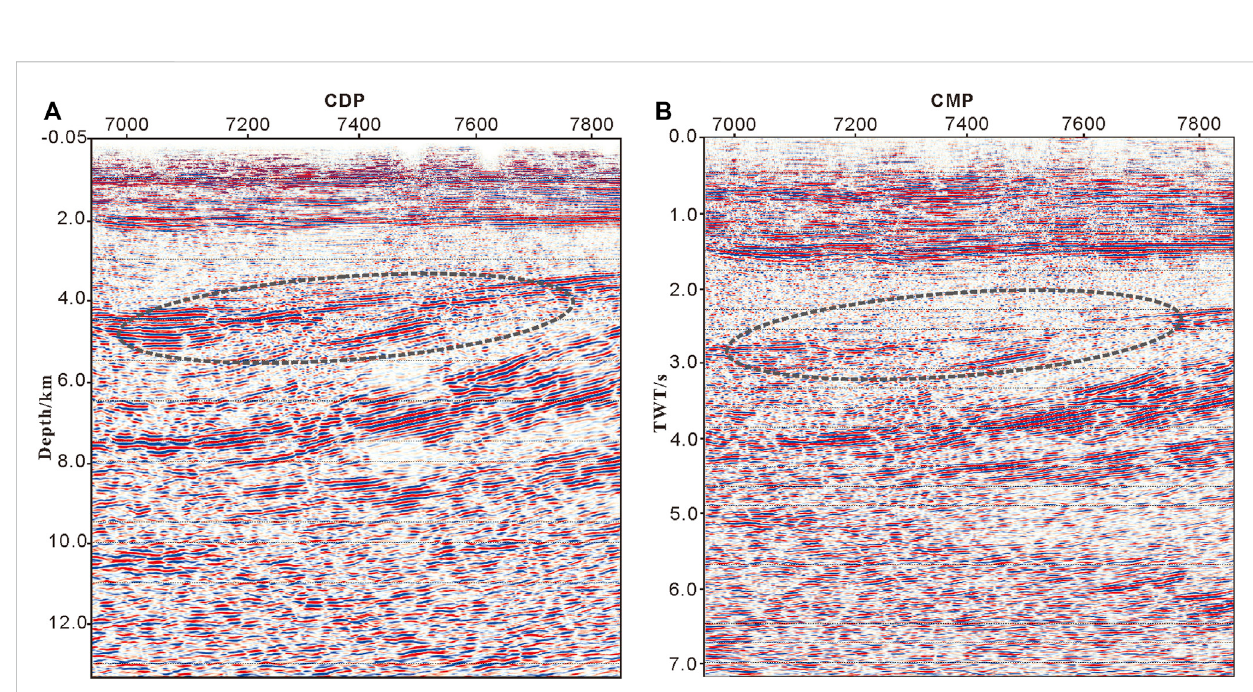
FIGURE 9 Local enlarged pro fi le comparison of the Baxian Sag of the PSDM pro fi le (A) and the PSTM pro fi le (B) . (The enlarged range is marked in Figure 7).